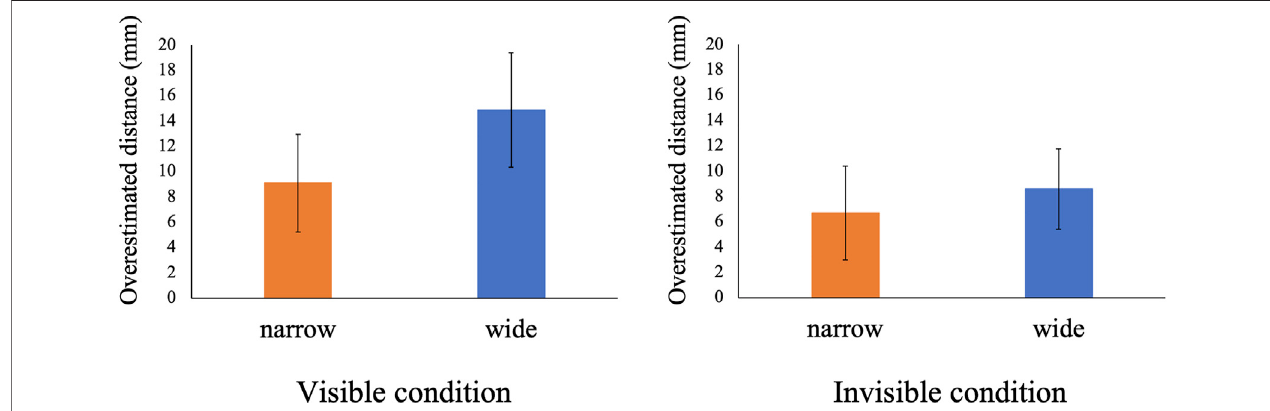
FIGURE3 | The mean oftheparticipant ’ sdistanceoverestimation under each condition inExperiment 1. Theleft fi gure shows the visible condition results, and the right fi gure shows the invisible condition results. The overestimated distance was de fi ned as the difference in the physical and the estimated distance between the reference point and the target. A positive value indicates distance overestimation. Error bars show the standard error.